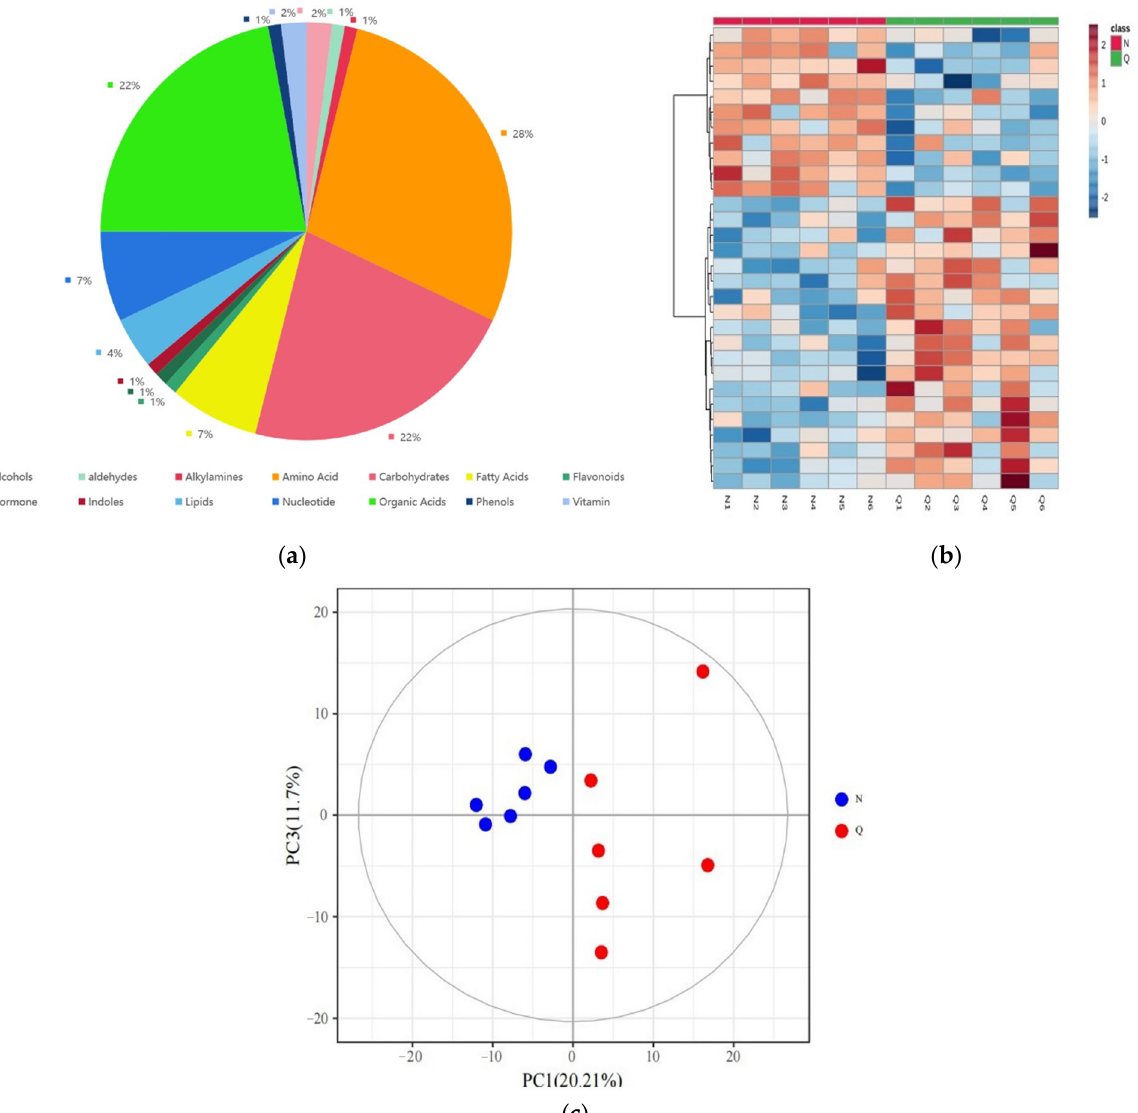
Figure 1. ( a ) Classification and proportion of total 404 metabolites detected in R. chrysanthum plants; ( b ) The heat map shows the cluster analysis of the top 30 metabolites in the control group, and the leaves of domesticated R. chrysanthum under UV-B irradiation. The color indicates the accumulation level of each metabolite. The redder indicates the higher the accumulation level of metabolite, while the bluer indicates the lower the accumulation level of metabolite; ( c ) Principal component analysis (PCA) of the control group and domesticated R. chrysanthum under UV-B irradiation.